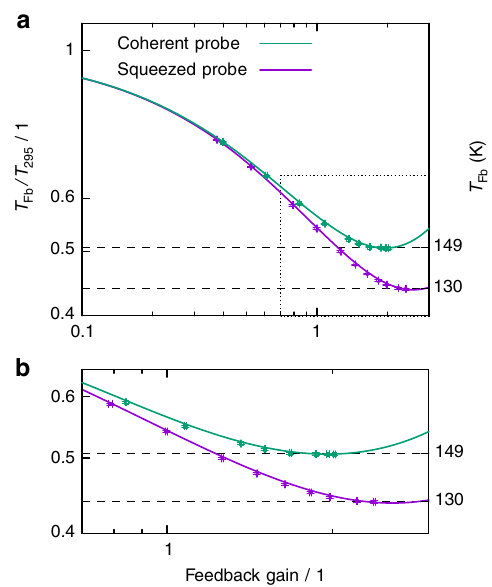
Figure 3 | Squeezed light enhanced feedback cooling. ( a ) Temperature ratio between the cooled and uncooled mechanical resonances (left axis) and the absolute temperatures T Fb (right axis) versus the feedback gain. Without feedback cooling, the temperature was 295K. Points represent measured data. The temperature was determined, in accordance to the equipartition theorem, by integrating the spectral density of the oscillator’s displacement. Error bars, calculated by means of a standard uncertainty propagation method, indicate the absolute error (see Supplementary Methods). Solid lines are given by equation (1). ( b ) A zoom into the region framed by a dashed rectangle in the upper plot. For higher gain settings, a squashing effect was observed (see Supplementary Figure 9). This is an effect of the in-loop measurement, correlating the mechanical motion and the measurement noise 23